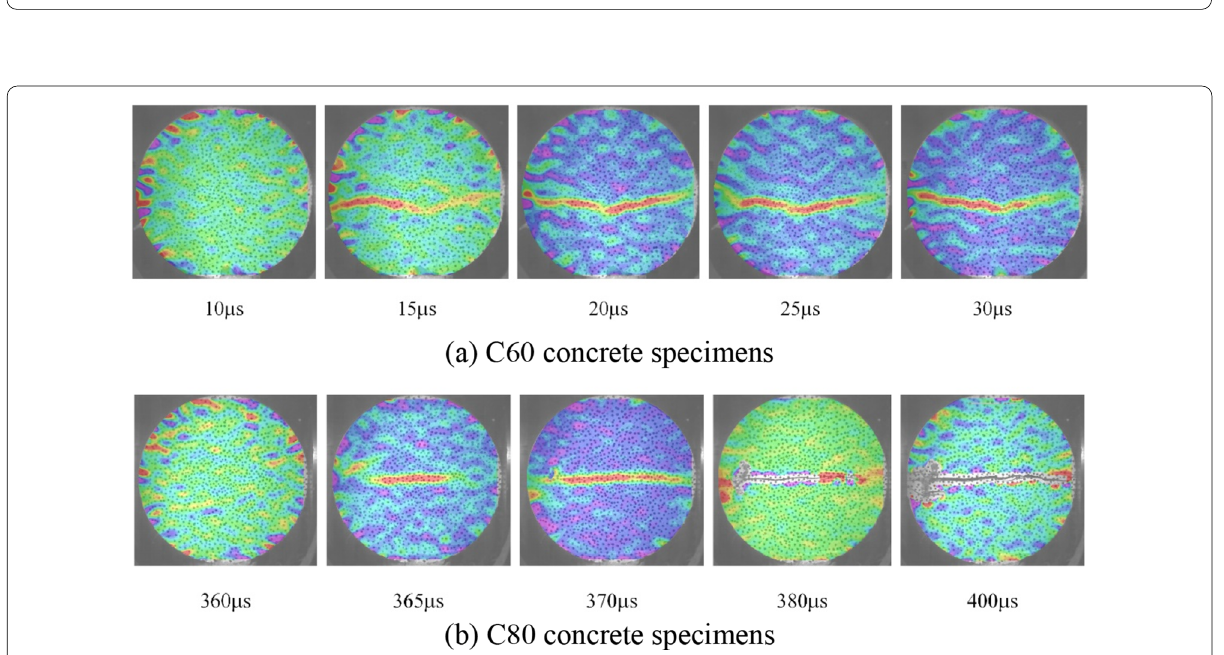
Fig. 12 Strain clouds of high-strength concrete under 0.05 MPa impact